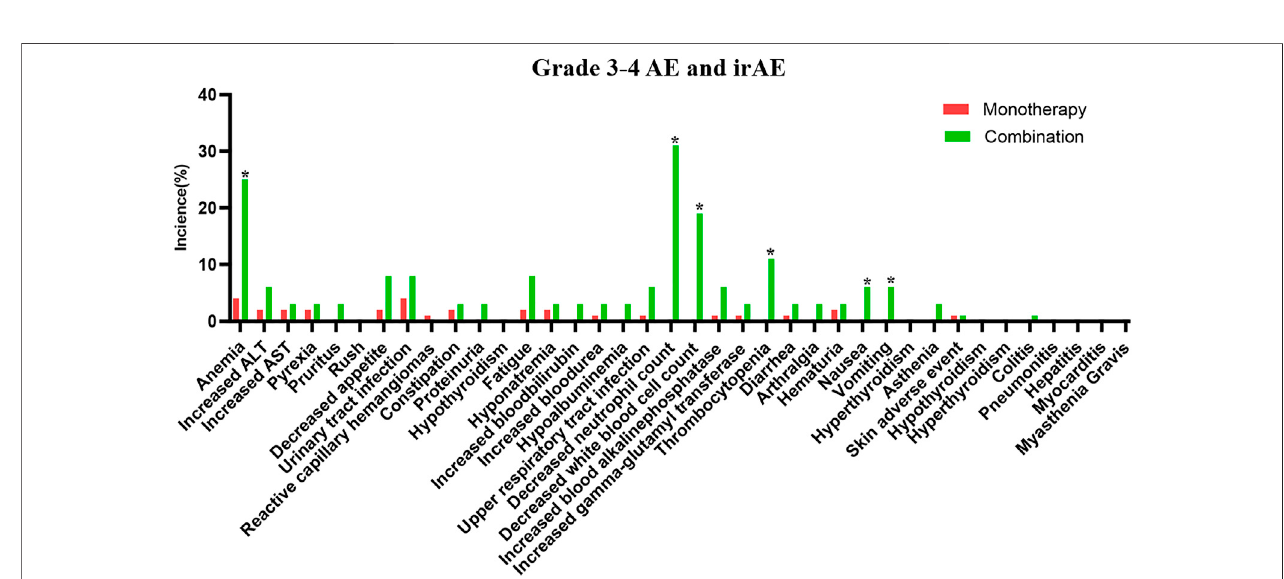
FIGURE 2 | The detailed grade 3 – 4 adverse events in PD-1 inhibitor and PD-1 inhibitor plus chemotherapy.